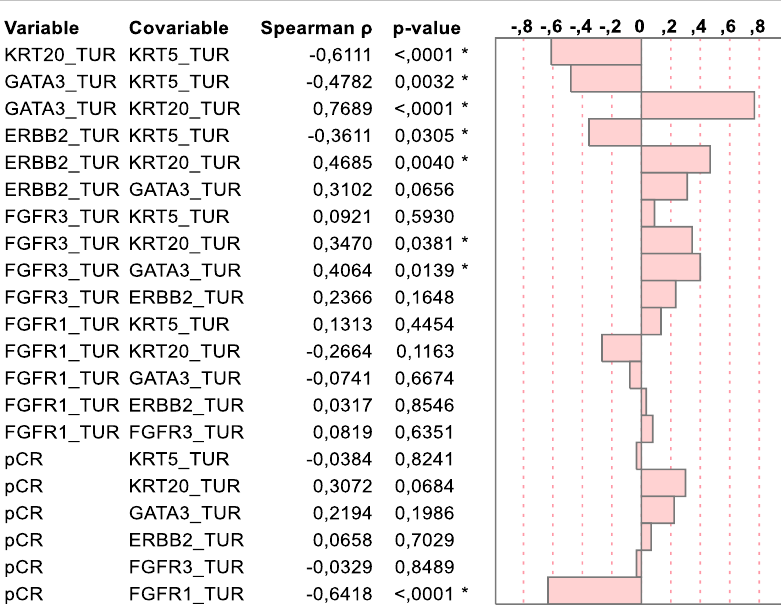
( B ) Figure 5. Contingency testing using ( A ) KRT20 mRNA and ( B ) FGFR1 mRNA in pre-therapy TUR biopsy samples for distinguishing responding from non-responding tumors. Tumors achieving pCR are depicted by red fields and resistant tumors are depicted by blue fields. Percentages of tumors in the stratification groups (high versus low expressors) are shown in the fields. The numbers on the left y-axis indicate the proportion in relation to all tumors, while the numbers on the right y-axis indicate the pCR categorization of the coloring with (1 = pCR achieved; 0 = no pCR). 3. Discussion